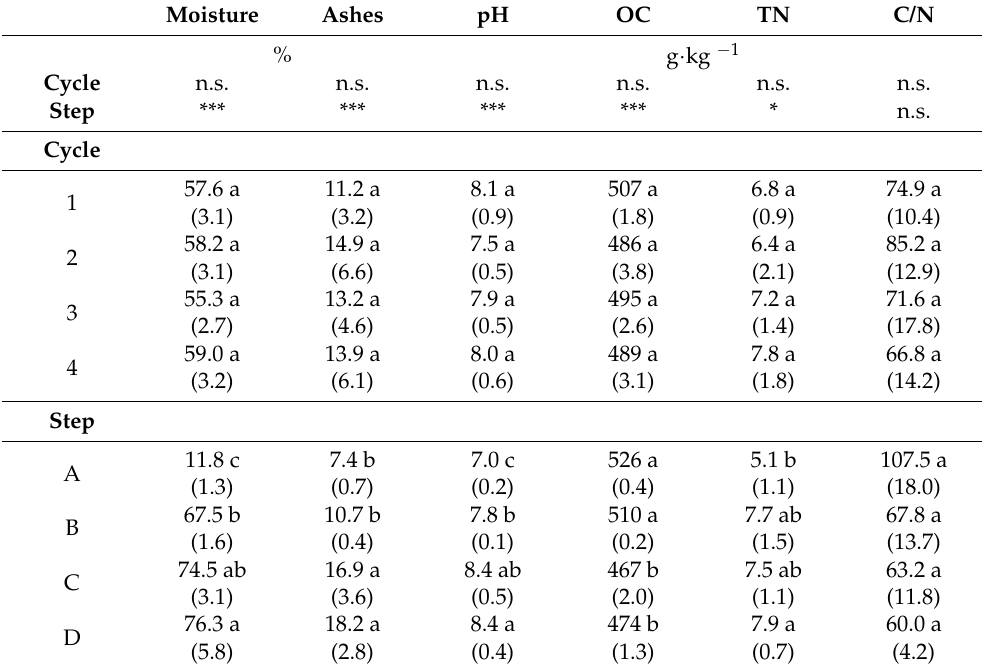
Table 3. Chemical analysis results of straw and substrates corresponding to different steps of preparation and different cycles of production. OC: organic carbon; TN: total nitrogen. Standard deviations are reported in parentheses. Different letters indicate significant differences among cycles ( p < 0.05). n.s.: not